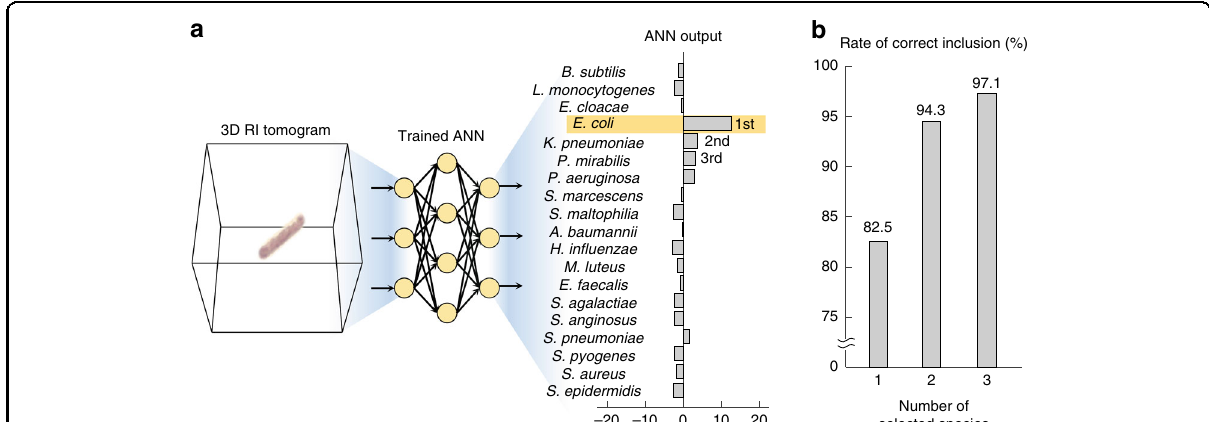
Fig. 4 Species identi fi cation using a single 3D RI tomogram. a The ANN processes a given 3D RI tomogram and results in the output indicating the 19 species. b Pinpointing the single most likely species based on the ANN output is 82.5% accurate in the blind test. The risk of omitting the ground true species is reduced by considering multiple likely species indicated in the ANN